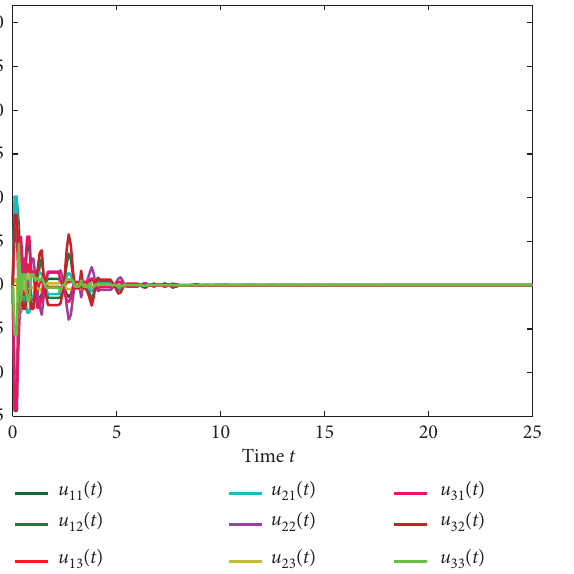
Figure 8: Trajectories of control inputs.